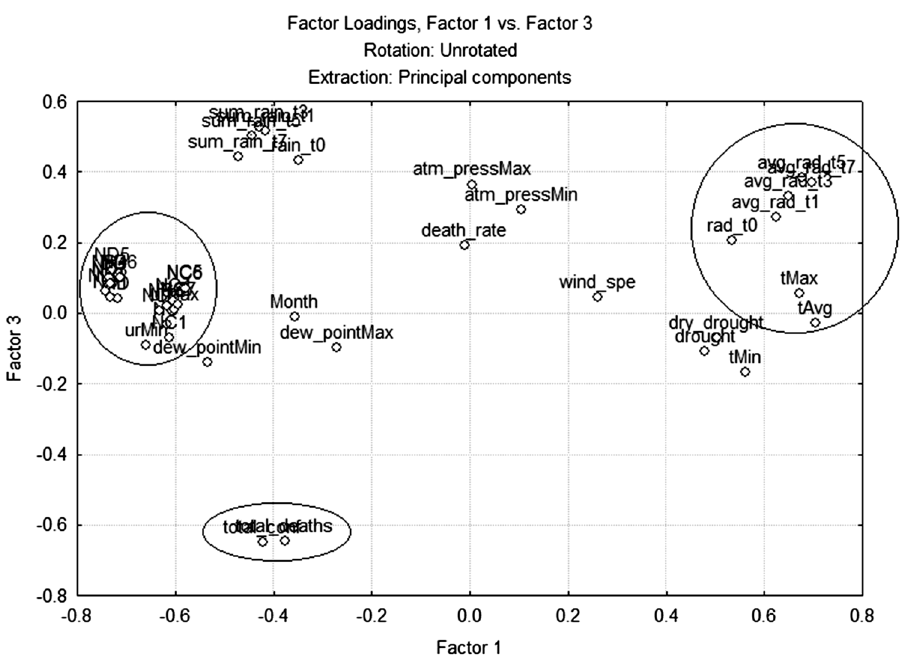
Figure 2. Analysis of the main components in Manaus (generated by the Statistica 7 software—https:// stati stica. softw are. infor mer.